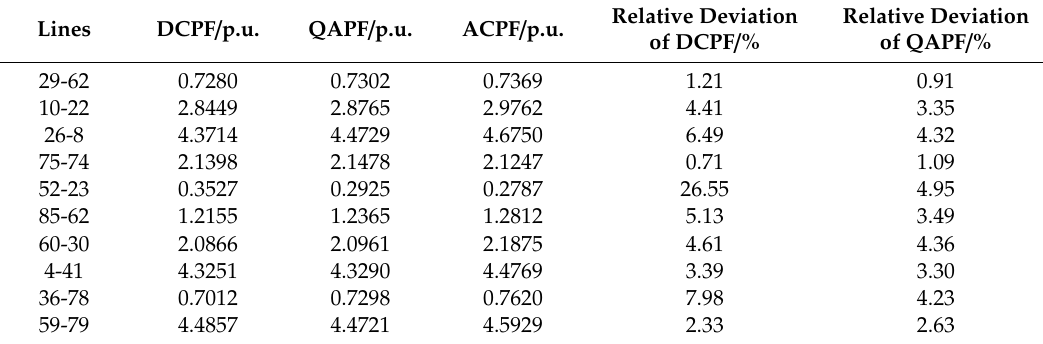
Table 7. Comparison of the active power of several lines computed by di ff erent power flow models. Lines